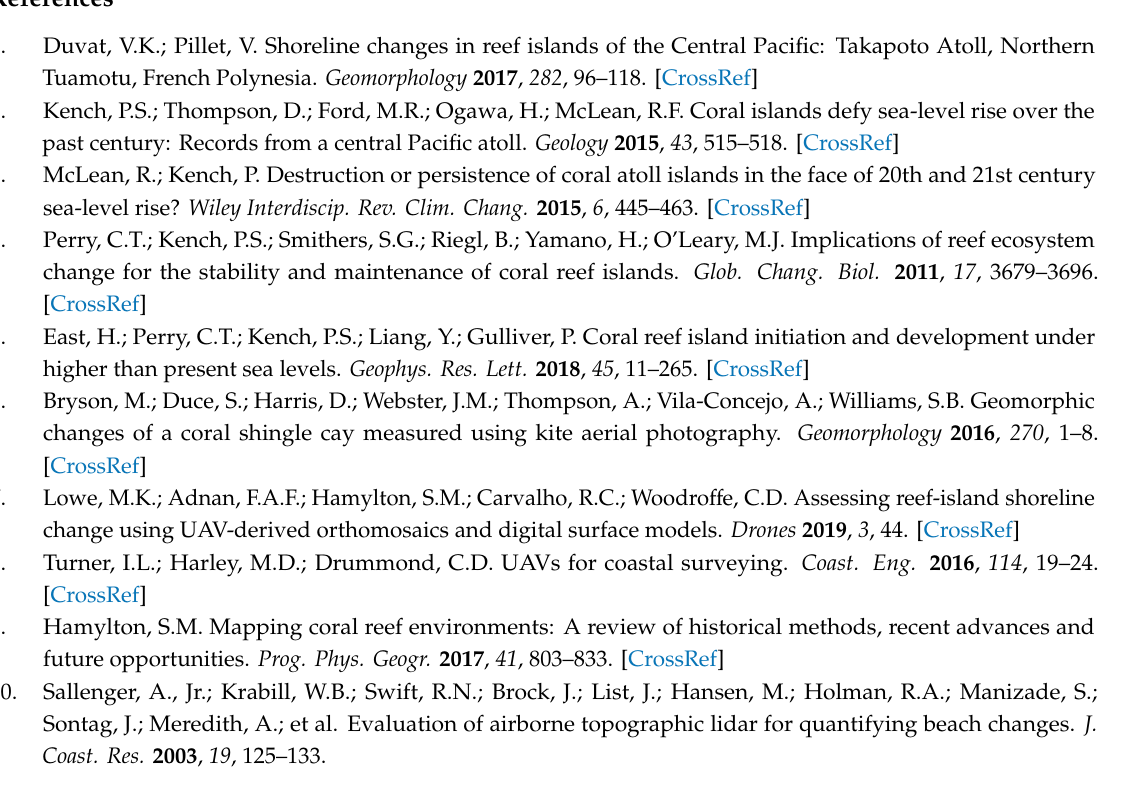
Figure S1: Methodology flow chart (including processing and analysis of DEM and Sentinel-2 imagery), Table S1: Tidal data corresponding to 22 islands survey during October 2016. Contour elevation of each island (m, AHD) compared against Highest Astronomical Tide (HAT) across the island archipelago, Table S2: Table of morphometric data for the 22 Pilbara reef islands. Data includes island area (ha), Reef platform area (ha), island volume (m3), Average and maximum elevation (m), perimeter scarping and island major axis orientation, Table S3: Table of morphometric data for the 22 Pilbara reef islands gathered from 2016 LiDAR used in the Principle components analyses. Factor scores derived from the PCA were normalised to generate an indexed value range between 1 and 0 (1 being high sensitivity characteristics and 0 low sensitivity characteristics), Table S4: Statistical results of PCA explaining total variance explained and components matrix (strength of individual parameters), Table S5: Table of morphometric data for the 22 Pilbara reef islands gathered from 2016 LiDAR used in the Principle components analyses. 2018 LiDAR data for 4 islands (Eva, Obs, Ashburton and Y) included to calculate change in ISCi between 2016 and 2018. Factor scores derived from the PCA were normalised to generate an indexed value range between 1 and 0 (1 being high sensitivity characteristics and 0 low sensitivity